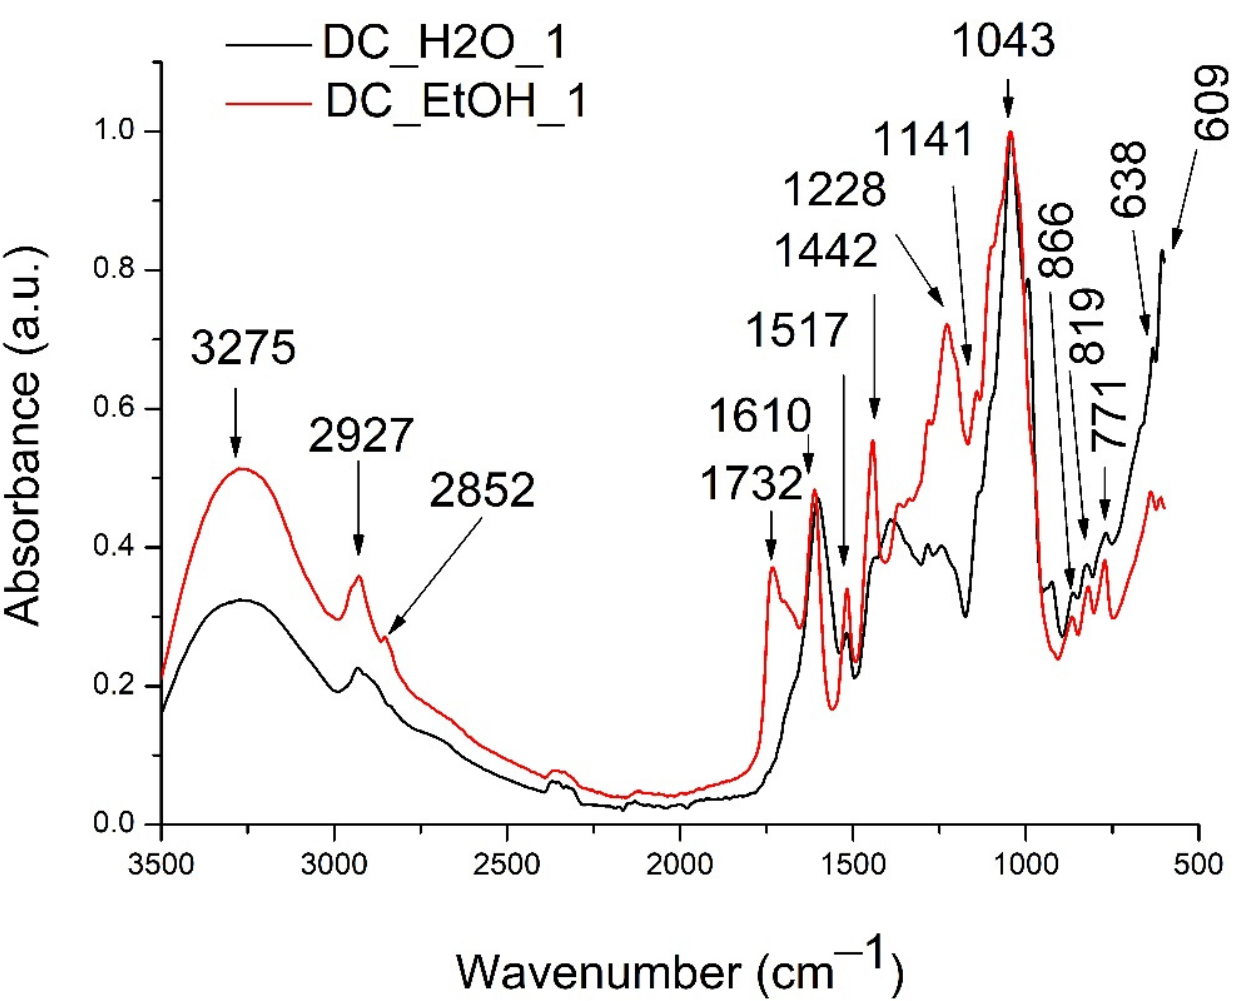
Figure 1. Dichrostachys cinerea water and ethanolic general FTIR spectra (3500–500 cm − 1 ). Dichrostachys cinerea water and ethanolic extracts had similar spectra, having 15